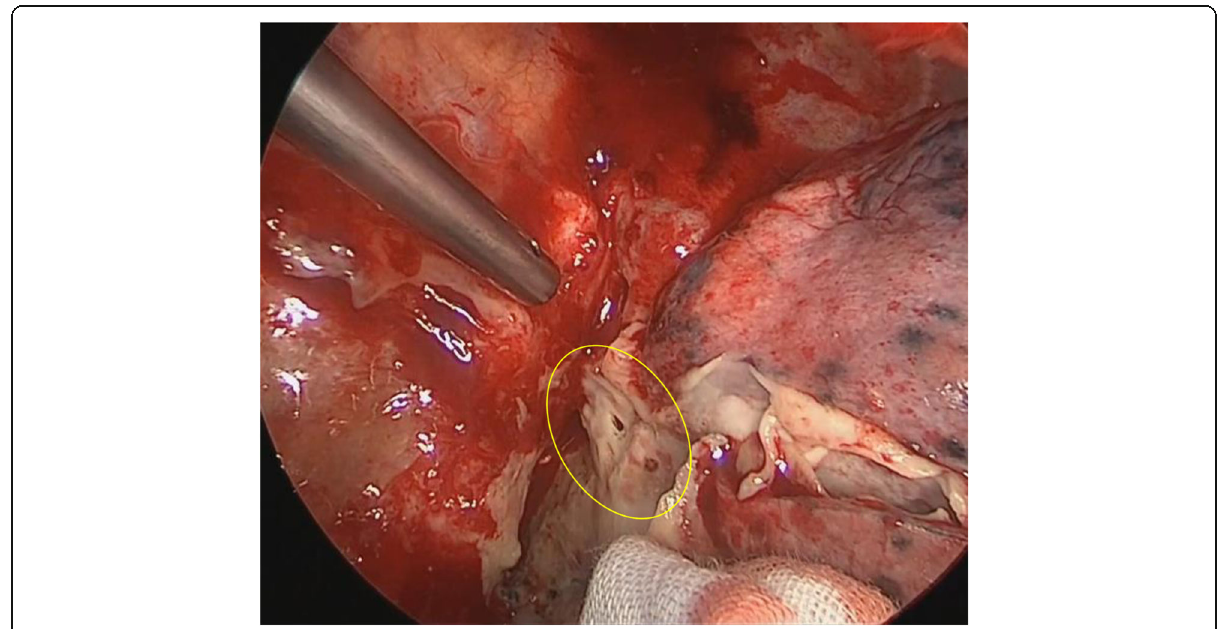
Fig. 3 Intraoperative views showing a fistula and necrotizing changes affecting the membranous portion of the right main bronchus (inner part of the yellow